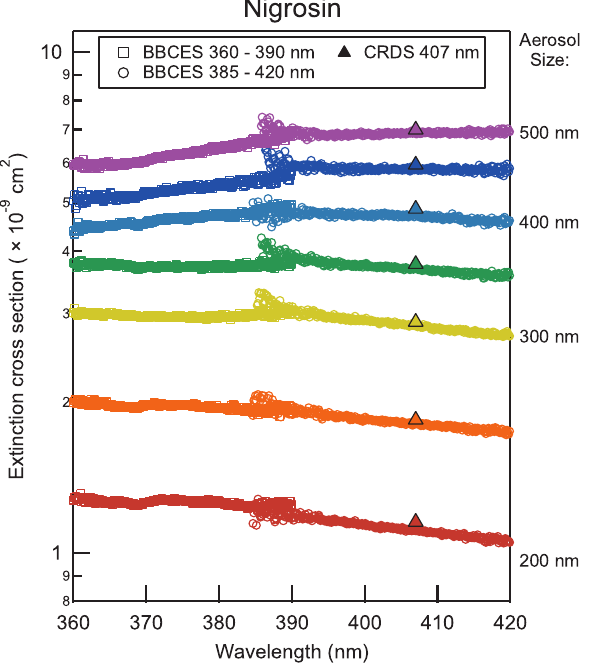
Fig. 7. Extinction cross sections as a function of wavelength for ni- grosin aerosol at 200–500 nm diameter measured with the BBCES 360–390nm, BBCES 385–420nm, and CRDS at λ = 407nm. The extinction cross sections shown in this plot have not been corrected for doubly and triply charged particles, because the refractive index of nigrosin as a function of wavelength is not well-known.